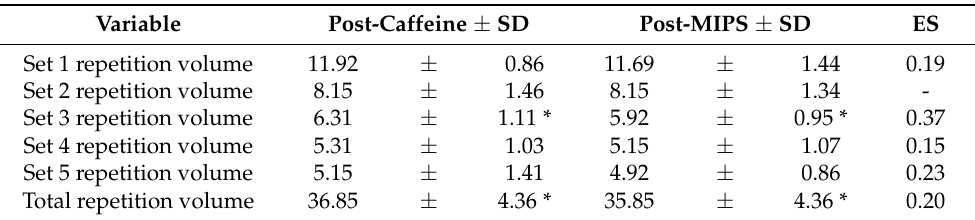
Table 2. Effects of caffeine and multi-ingredient pre-workout supplement (MIPS) ingestion on bench press repetition volume.